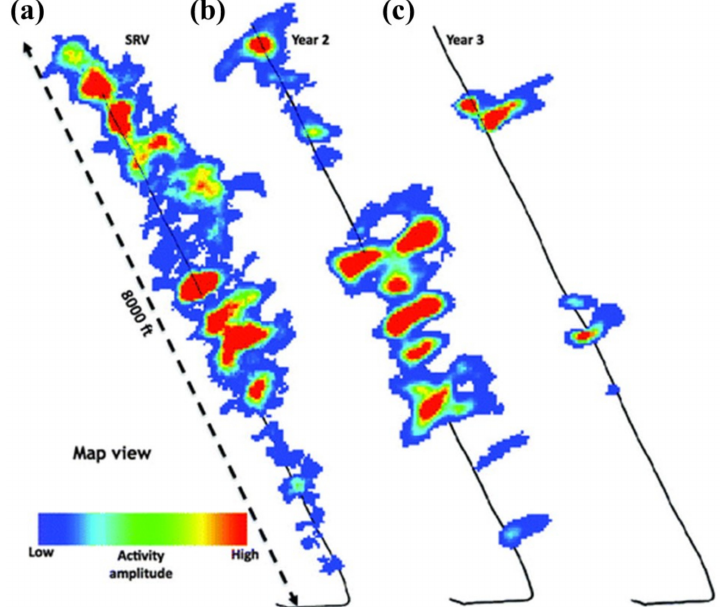
Figure 16. Changes in APV along the wellbore during the initial hydraulic fracturing and at two later times. ( a ) The activated fractures (SRV) during hydraulic fracturing. ( b ) The producing (APV) volume after 2 years of production. ( c ) The APV after 3 years of production. After